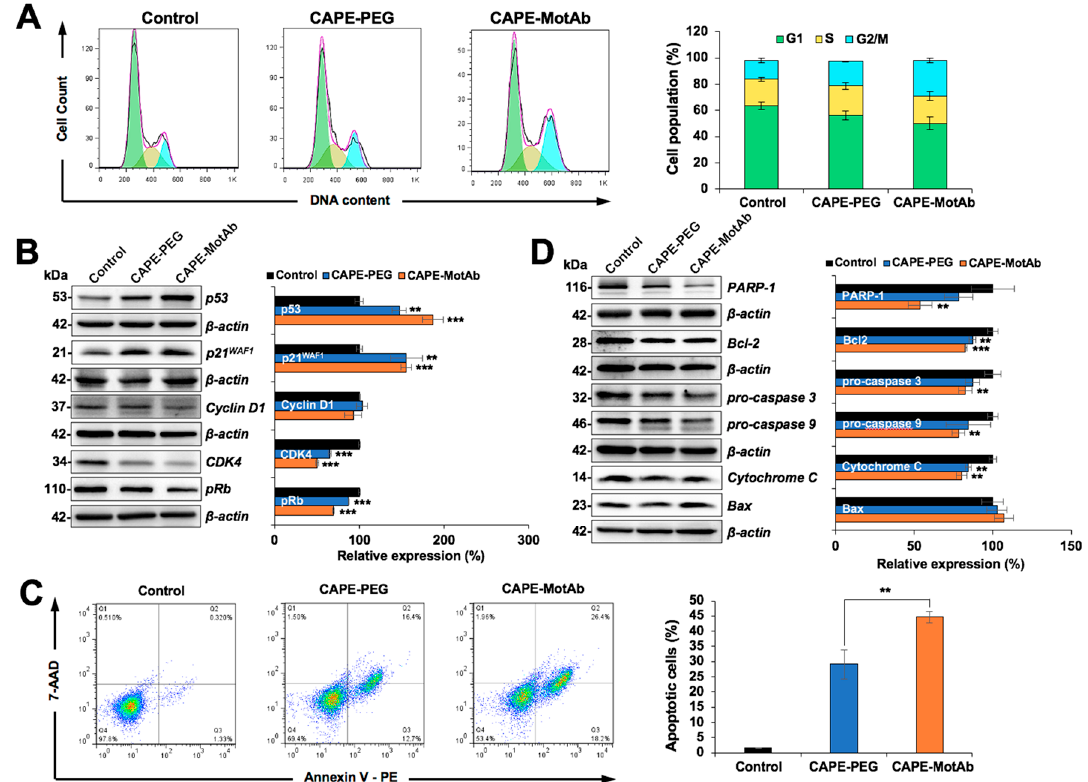
Figure 5. Stronger cell cycle arrest and apoptosis induced by CAPE-MotAb in A549 cells. ( A ) Cell cycle analysis of CAPE-MotAb treated A549 cells after 24-h incubation showing an increase in cell population in the G2 / M phase in comparison to CAPE-PEG treated A549 cells. Quantitation of cell population from three independent experiments. ( B ) Western blot for cell cycle regulatory proteins (p53, p21 WAF1 , Cyclin D1, CDK4, and pRb) after 48-h incubation of CAPE-MotAb. Quantitation of the results is shown on the right (mean ± SD, n = 3), ** p < 0.01, *** p < 0.001 (Student’s t-test to control). ( C ) Apoptosis analysis from flow cytometry after 48-h incubation showing a sharp increase in apoptotic cells when treated with CAPE-MotAb. Quantitation of apoptotic cells from three independent experiments (mean ± SD, n = 3), ** p < 0.01 (Student’s t-test). ( D ) Western blot for apoptotic proteins (PARP-1, Bcl-2, pro-caspase 3, pro-caspase 9, Cytochrome C, and Bax) after 48-h incubation of cells with CAPE-MotAb. Quantitation of the results is shown on the right (mean ± SD, n = 3), ** p < 0.01, *** p < 0.001 (Student’s t-test to control). A549 cells were treated with an equivalent dose of CAPE (10 µ g / mL) for all the above